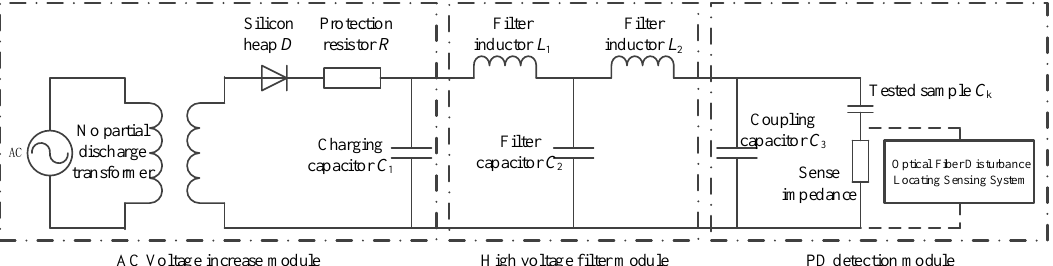
Figure 5. Schematic diagram of partial discharge detection wiring of an XLPE